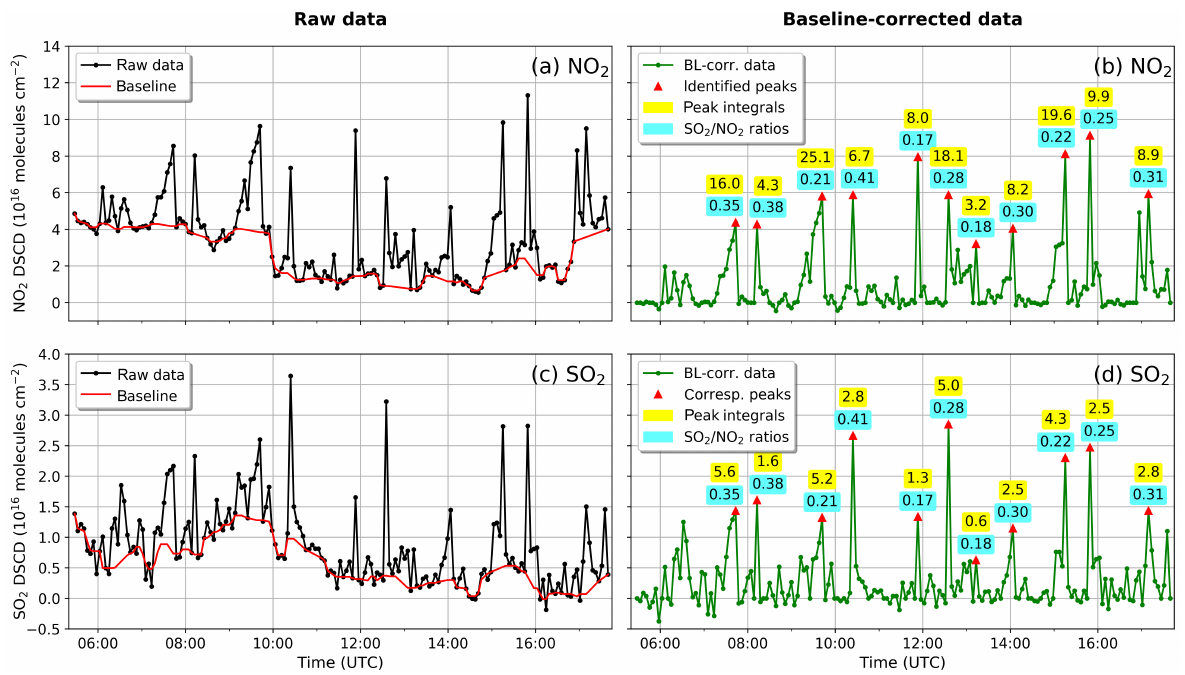
Figure 18. Calculation of SO 2 -to-NO 2 ratios for ship emission peaks for one example day (23 July 2014) before the change in sulfur emission limits. Panel (a) shows the UV NO 2 DSCD raw data for 0.5 ◦ elevation and − 25 ◦ azimuth and the determined baseline. Panel (b) shows the baseline-corrected NO 2 data for which the automatically identified peaks are highlighted with red triangles. Numbers close to the peaks denote the peak integrals in 10 16 moleculescm − 2 (marked in yellow) and the SO 2 -to-NO 2 ratios (marked in blue). Panels (c) and (d) show the corresponding plots for SO 2 .